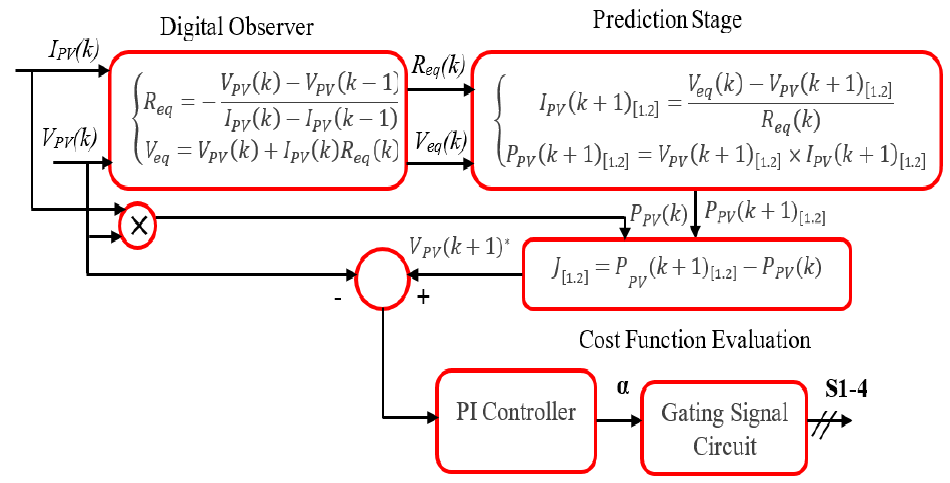
Figure 5. Block diagram of the proposed fixed frequency phase-shift MPPT predictive control.